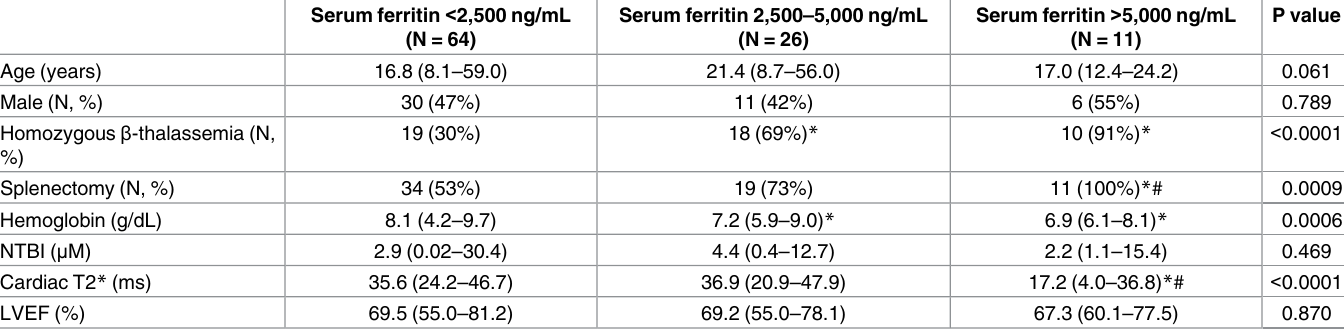
Table 1. Baseline clinical and laboratory characteristics according to the mean serum ferritin during the past 5 years.